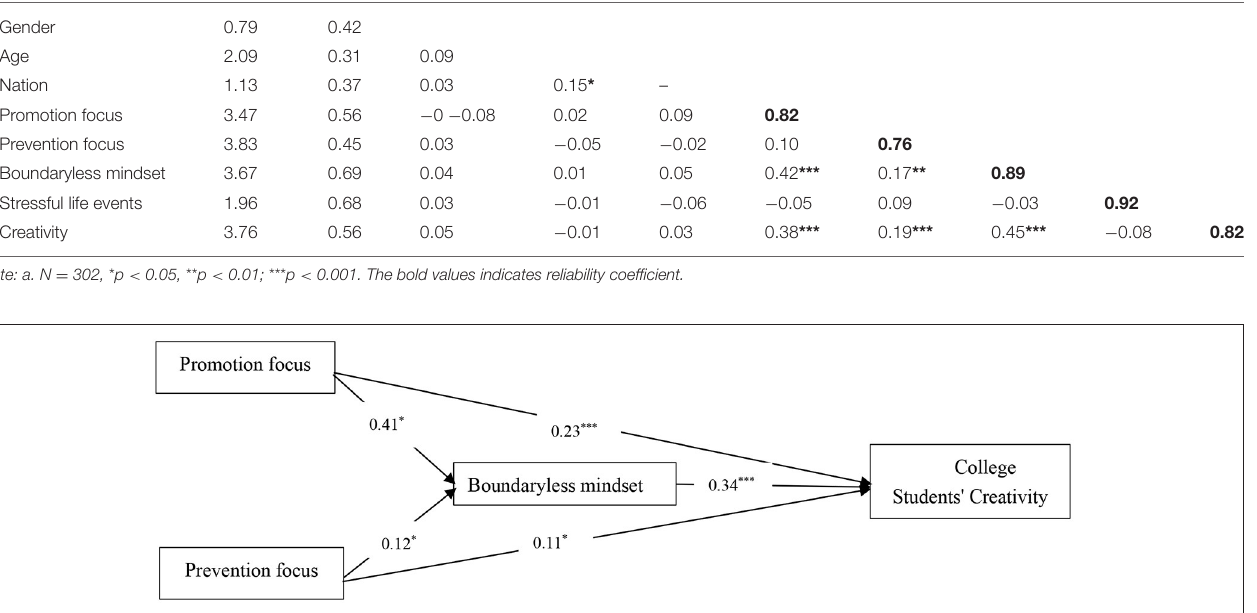
TABLE 1 | Means, standard deviations, correlation coefficients between variables and reliability coefficients. Variables